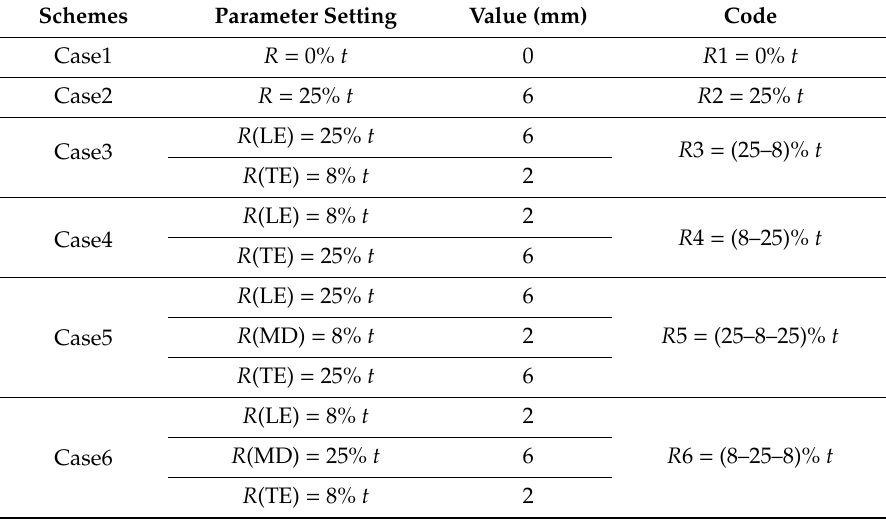
Table 3. Fillet configuration parameters and